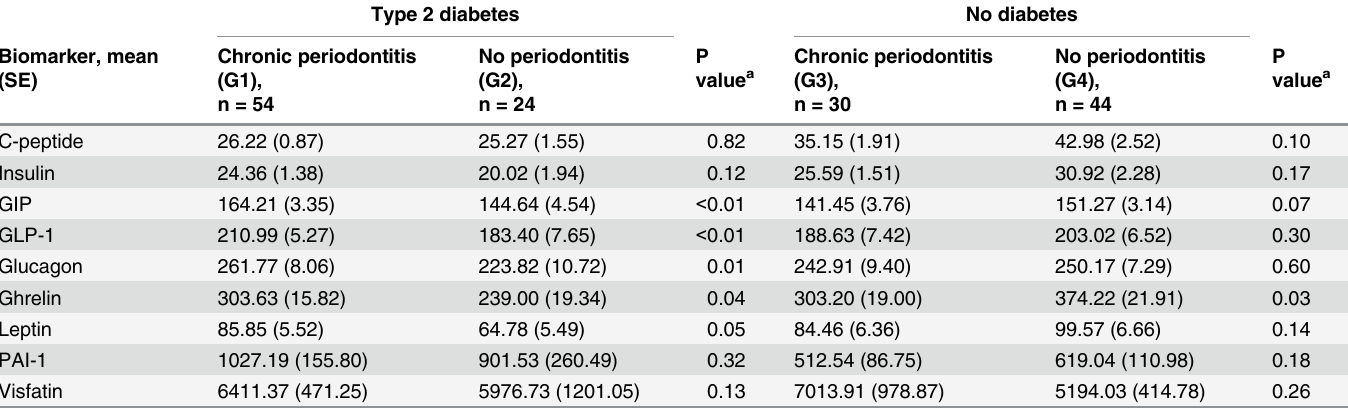
Table 2. Amounts of the detected glucoregulatory biomarkers (pg/30 s).